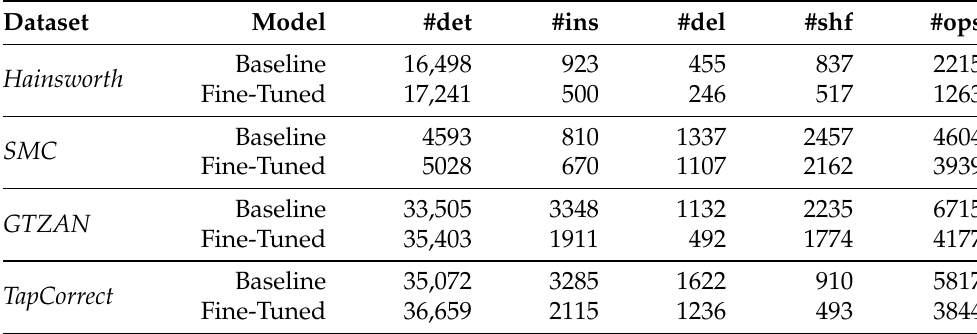
Table 3. Global number of atomic edit operations: correct detections (#det), insertions (#ins), deletions (#del), shifts (#shf) and total edit operations (#ops) for the different test datasets.